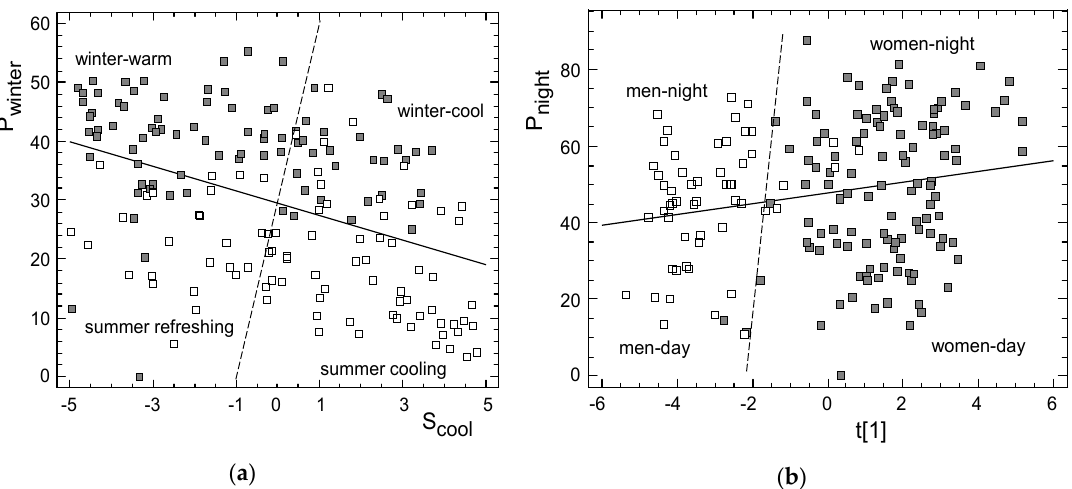
Figure 5. Sensory maps of 176 fragrances. Dashed lines were drawn to divide the scatterplot into four meaningful sections. ( a ) Fitted linear regression between winter preference ( P winter ) versus cool odor character ( S cool ). Filled points: t (2) < 0 (i.e., warm perfumes); ( b ) plot of fitted linear regression between preference for nighttime wear ( P night ) versus t (1) scores obtained from the final PCA. Filled points: women’s fragrances.